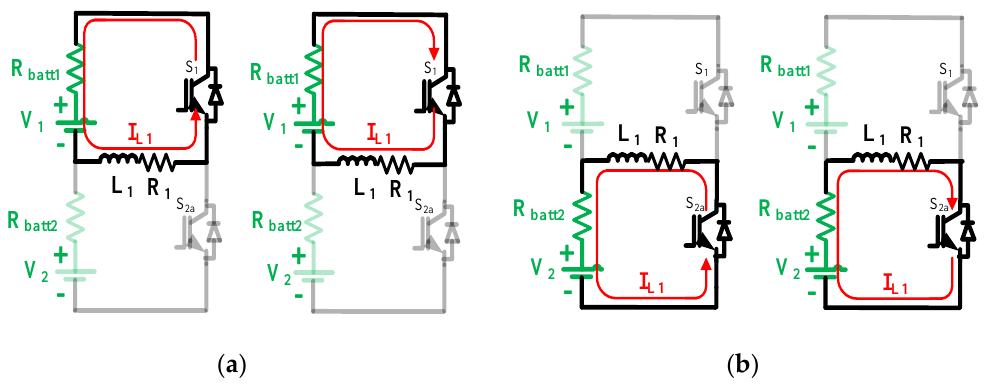
Figure 5. Operating modes for the preheating mechanism and SoC balancing [16].